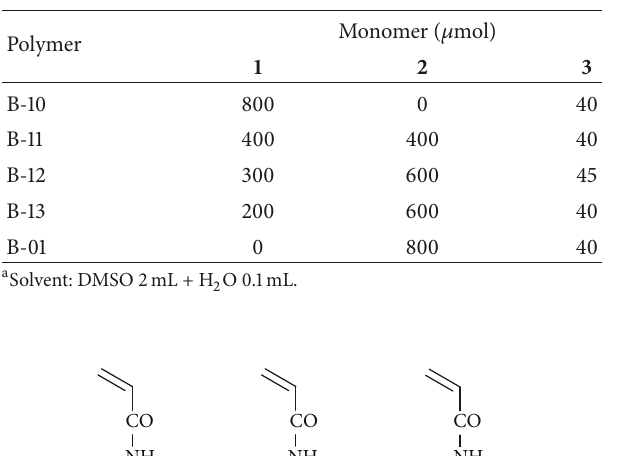
Table 1: Monomer compositions of copolymers a .